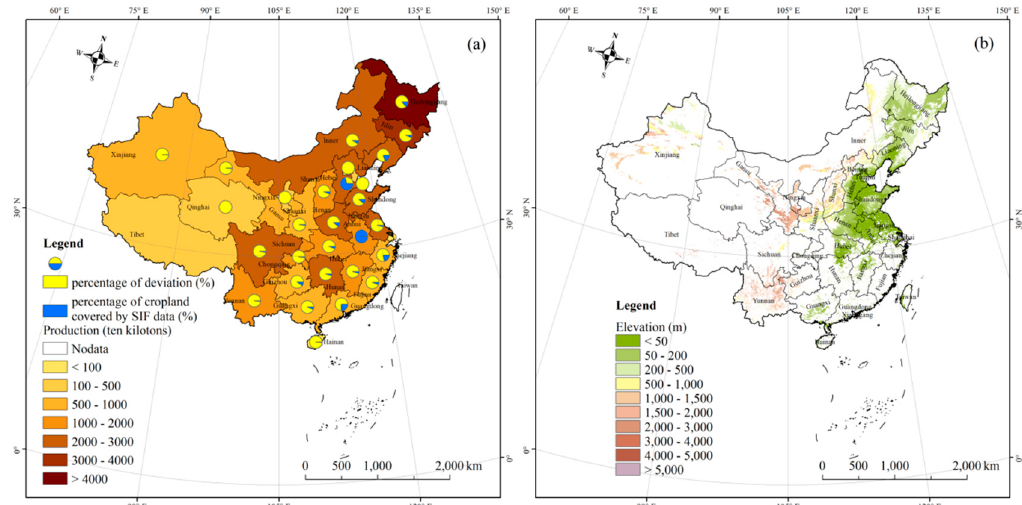
Figure 4. The spatial distribution of the government’s autumn crop production statistics, the percentage of deviation of the autumn crop production estimated by using SIF757 in 2016, and the percentage of cropland covered by solar-induced chlorophyll fluorescence (SIF) data in each province ( a ); and, topography of Chinese cropland ( b ).